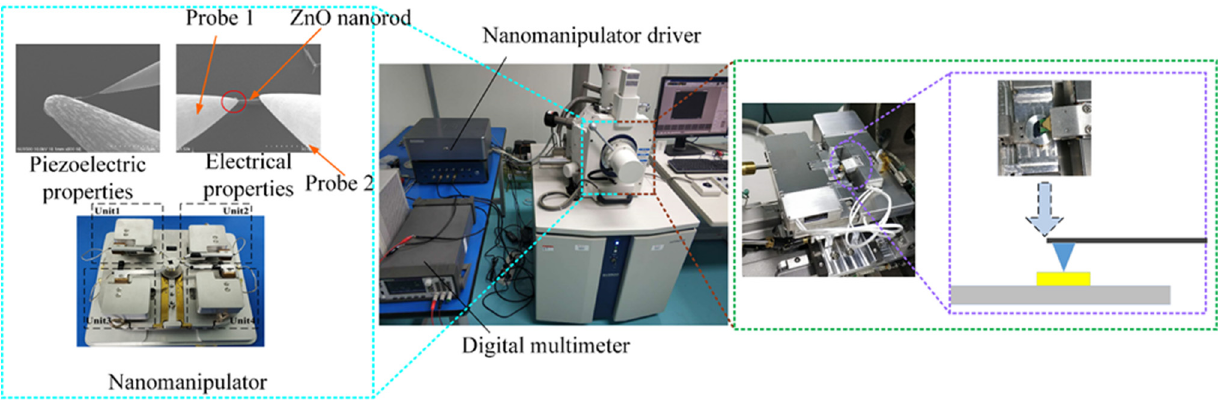
Figure 4. Mechanical/electrical characterization experimental apparatus. On the left is the electrical/piezoelectric characterization system (The point that a probe contacts ZnO nanorods is called irradiation point, as red dotted line marks), in the middle is the SEM, and on the right is the morphology and mechanical characterization system.